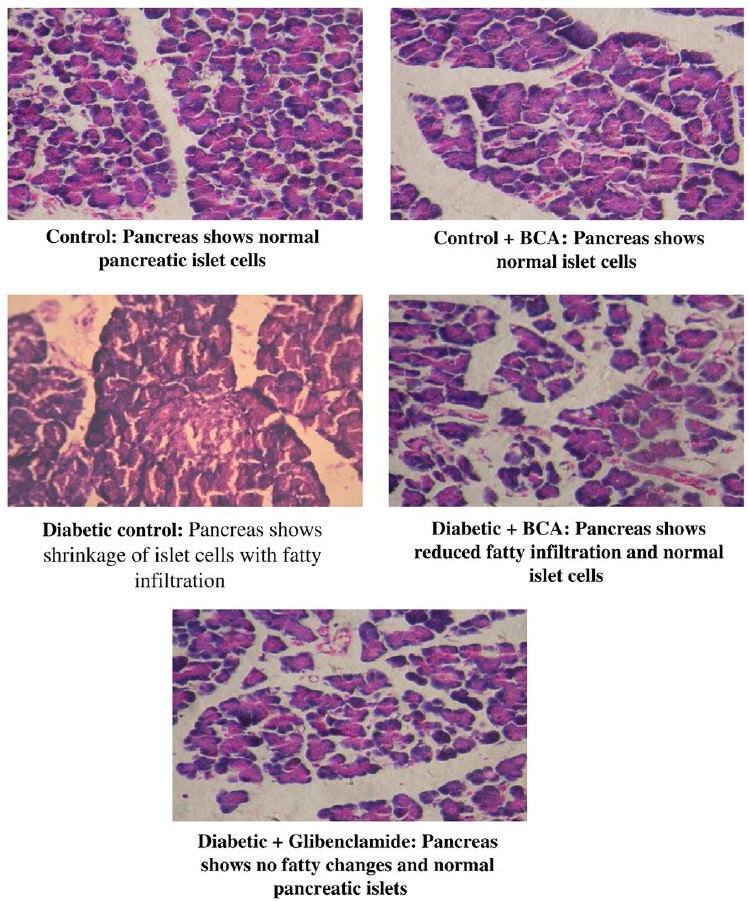
Figure 3. Effect of BCA on the pancreatic tissue in streptozotocin diabetic rats. Reprinted with permission from Ref. [22].